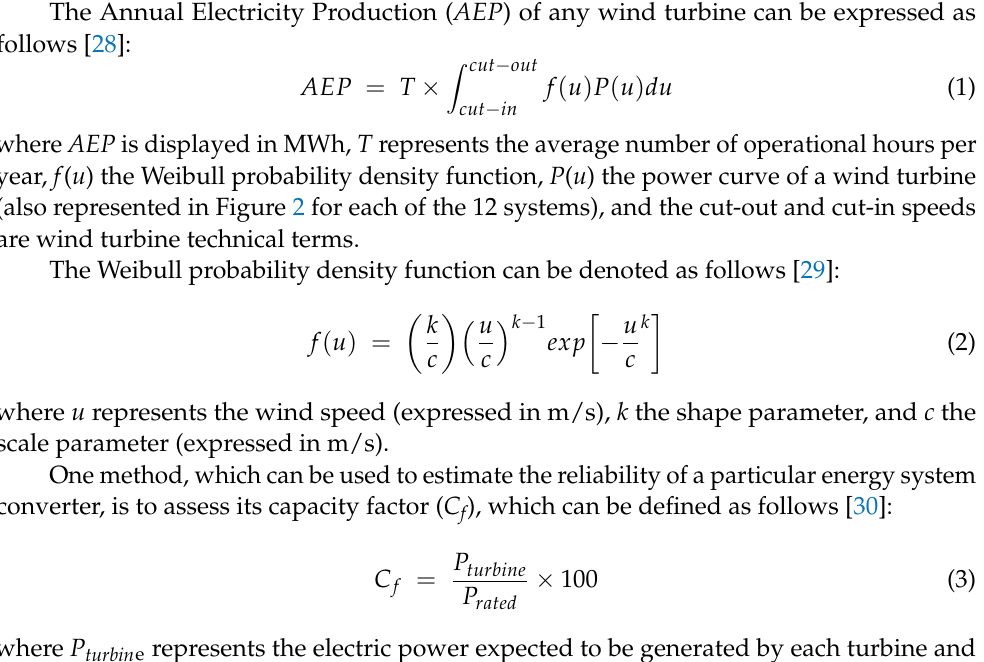
Figure 2. Representation of the wind turbine power curves considered for this